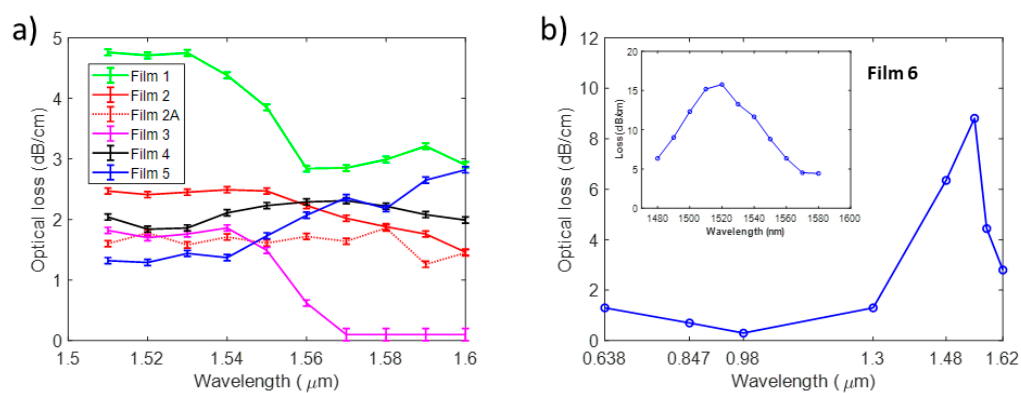
Figure 3. ( a ) Optical loss of various films determined via prism coupling from 1510 to 1600 nm. ( b ) Optical loss determined via prism coupling at various wavelengths in the visible to infrared for Film 6 and finer spaced loss measurements from 1480 to 1580 nm (inset). Connecting lines are to help guide the eye.